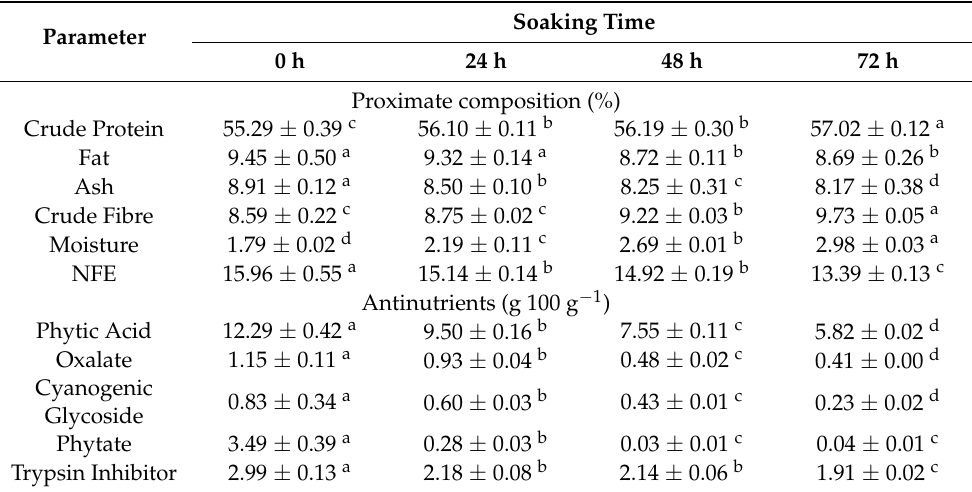
Table 1. Proximate analysis and antinutrients of Jatropha curcas kernel socked for different durations (g 100 g − 1 ). Numbers are means ± standard